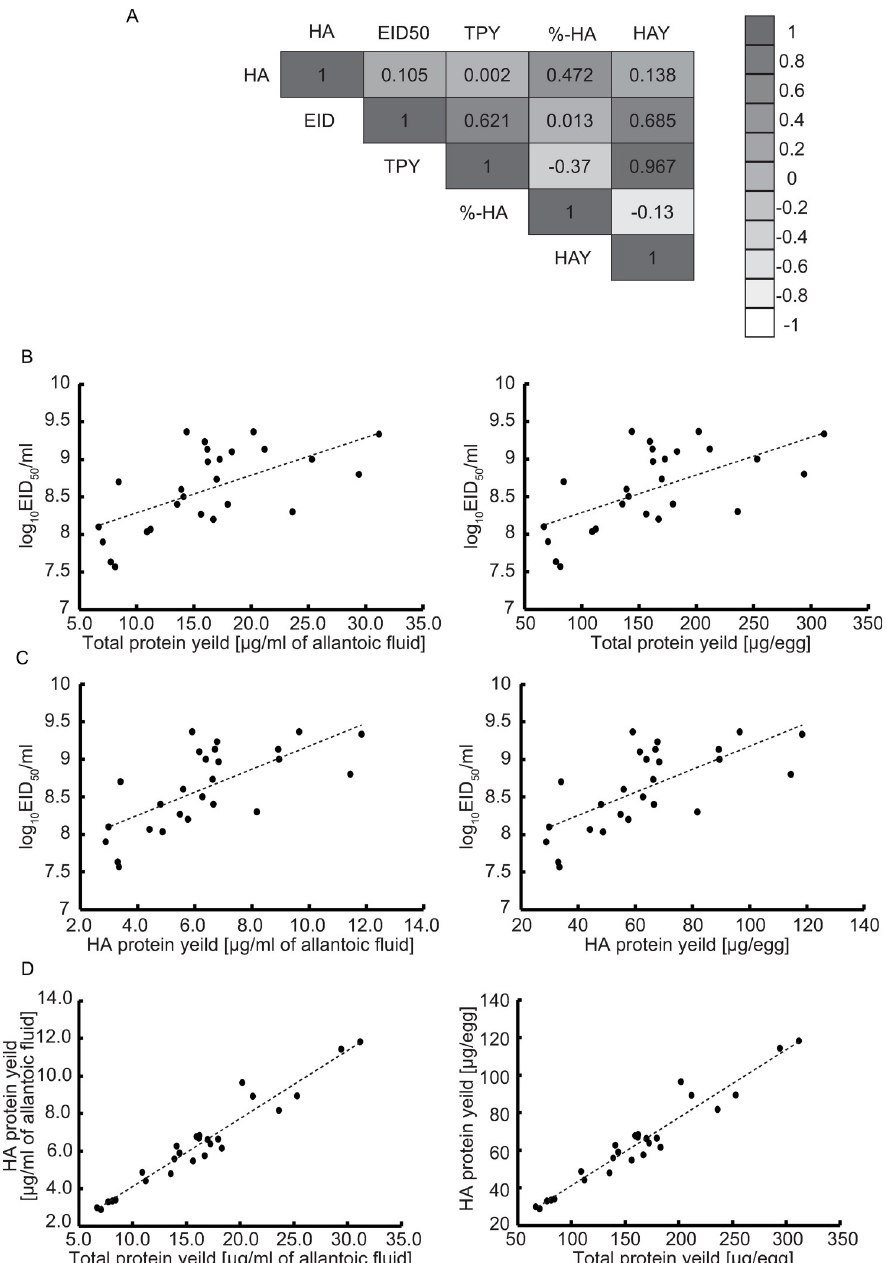
Fig 1. Correlations between different virus characteristics. The Pearson correlation coefficients among viral characteristics were calculated using R version 4.1.1 software 13) . (A) The correlation matrix of virus characteristics is shown. The abbreviations of each characteristic are as follows: HA titer (HA), 50% Egg Infectious Dose (EID50), total protein yield (TPY), %-HA content (%-HA), HA antigen yield (HAY). (B) Correlations between the EID50 and TPY of 26 H5 CVVs. (C) Correlations between the EID50 and HAY of 26 H5 CVVs. (D) Correlations between the HAY and TPY of 26 H5 CVVs.